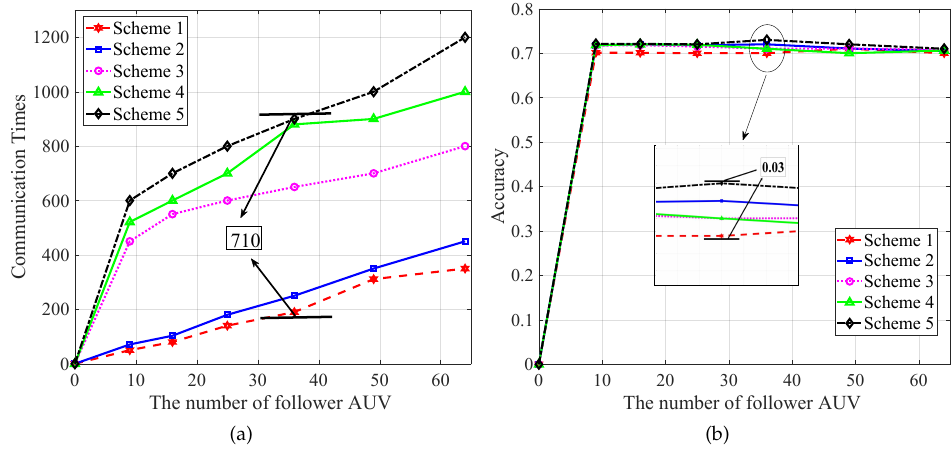
Figure 4. The relationship between communication times and accuracy. ( a ) Comparison of the communication times of different schemes versus the number of follower AUVs. ( b ) Comparison of the accuracy of different schemes versus the number of follower AUVs.